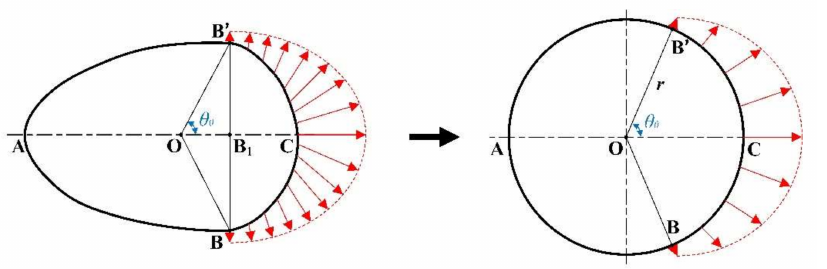
Figure 2. Section ellipse and simplified circle model.